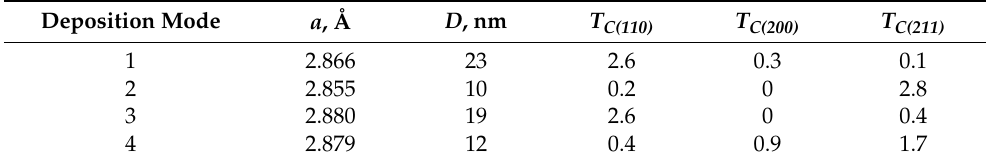
Figure 6. XRD diffractograms of Cr coatings obtained on AISI 321 steel substrates depending on their deposition modes. Table 2. Structural parameters of Cr